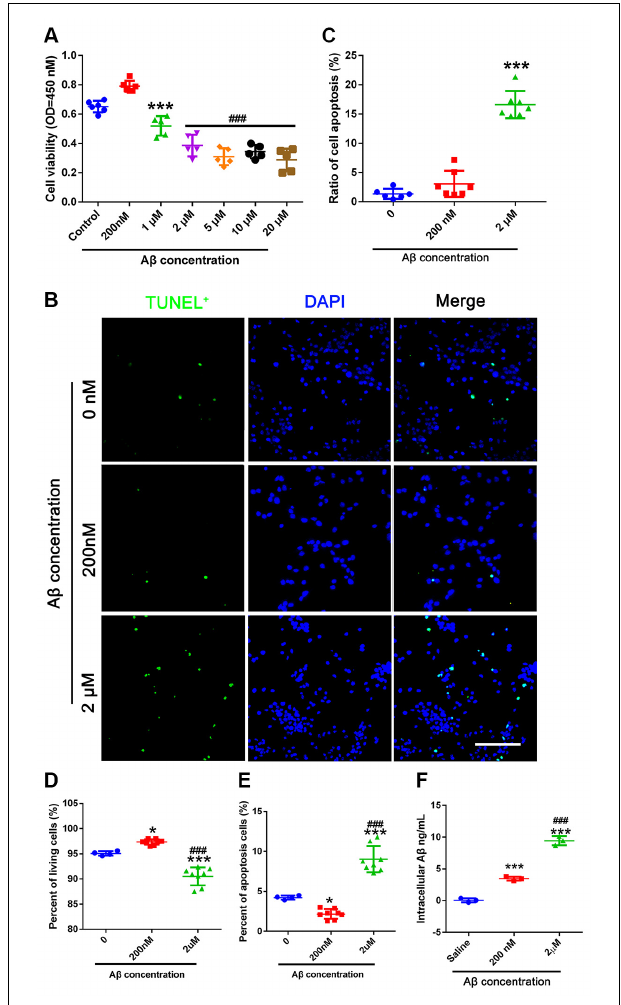
FIGURE 2 | Different concentrations of A β affect NSC apoptosis. (A) CCK-8 was used to detect cell viability. NSCs were passed for 2–4 generations and plated into 96-well plates. Different concentrations of A β oligo were added for 24 h before the CCK-8 test. *** represents 1 µ M vs. control group, P = 0.011. ### represents 2–20 µ M vs. control group, P < 0.0001. (B) TUNEL was used to obtain apoptotic cell numbers in 0 µ M A β -, 200 nM A β -, and 2 µ M A β -treated NSCs. (C) The ratio of TUNEL (green) positive cells compared to DAPI (blue) was calculated. *** represents 2 µ M A β vs. 0 µ M A β , P < 0.0001. Scale bar = 50 µ m. (D) NSCs treated with 0 µ M A β , 200 nM A β , and 2 µ M A β were harvested 24 h after A β treatment and stained with PI/AnnexinV for flow cytometry analysis. The percentage of living cells was calculated. * represents 200 nM A β vs. 0 µ M A β , P = 0.0181, *** represents 2 µ M A β vs. 0 µ M A β , P < 0.0001, ### represents 2 µ M A β vs. 200 nM A β , P < 0.0001. (E) Cells were treated as mentioned in (D) . The percentage of apoptotic cells was calculated. * represents 200 nM A β vs. 0 µ M A β , P = 0.0236, *** represents 2 µ M A β vs. 0 µ M A β , P < 0.0001, ### represents 2 µ M A β vs. 200 nM A β , P < 0.0001. (F) 0 µ M, 200 nM, and 2 µ M A β were added to NSCs for 6 h. Intracellular A β was detected using the A β 1–42 -ELISA kit. *** represents 200 nM A β vs. 0 µ M A β , P = 0.0003, *** represents 2 µ M A β vs. 0 µ M A β , P < 0.0001, ### represents 2 µ M A β vs. 200 nM A β . NSC, neural stem cells; CCK-8, cell counting kit 8; TUNEL, terminal deoxynucleotidyl transferase dUPT nick end labeling; DAPI, 4 (cid:48) ,6-diamidino-2-phenylindole;